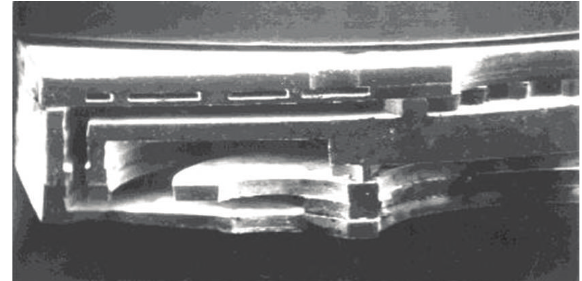
Figure 17: Micro gas turbine, SEM image [49].